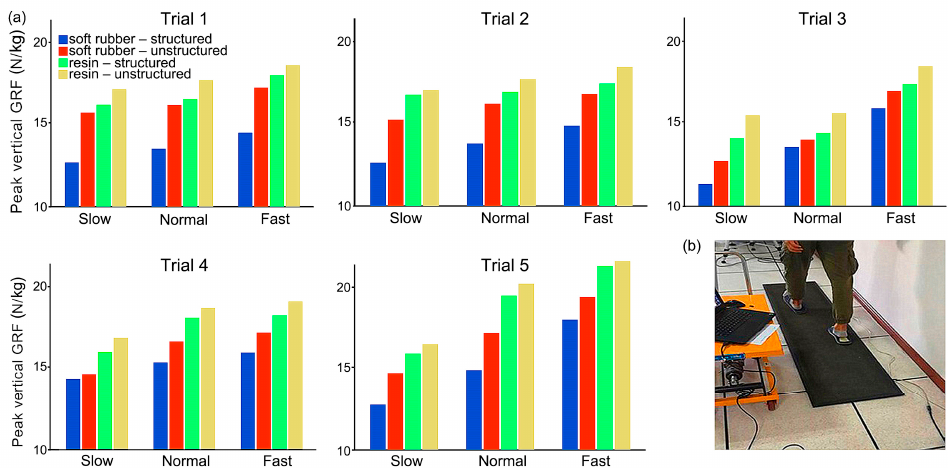
Figure 8. ( a ) Vertical GRF of all the five trials ( n = 5) during human walking at different speeds; ( b ) Setups for human walking tests wearing the bionic pads.